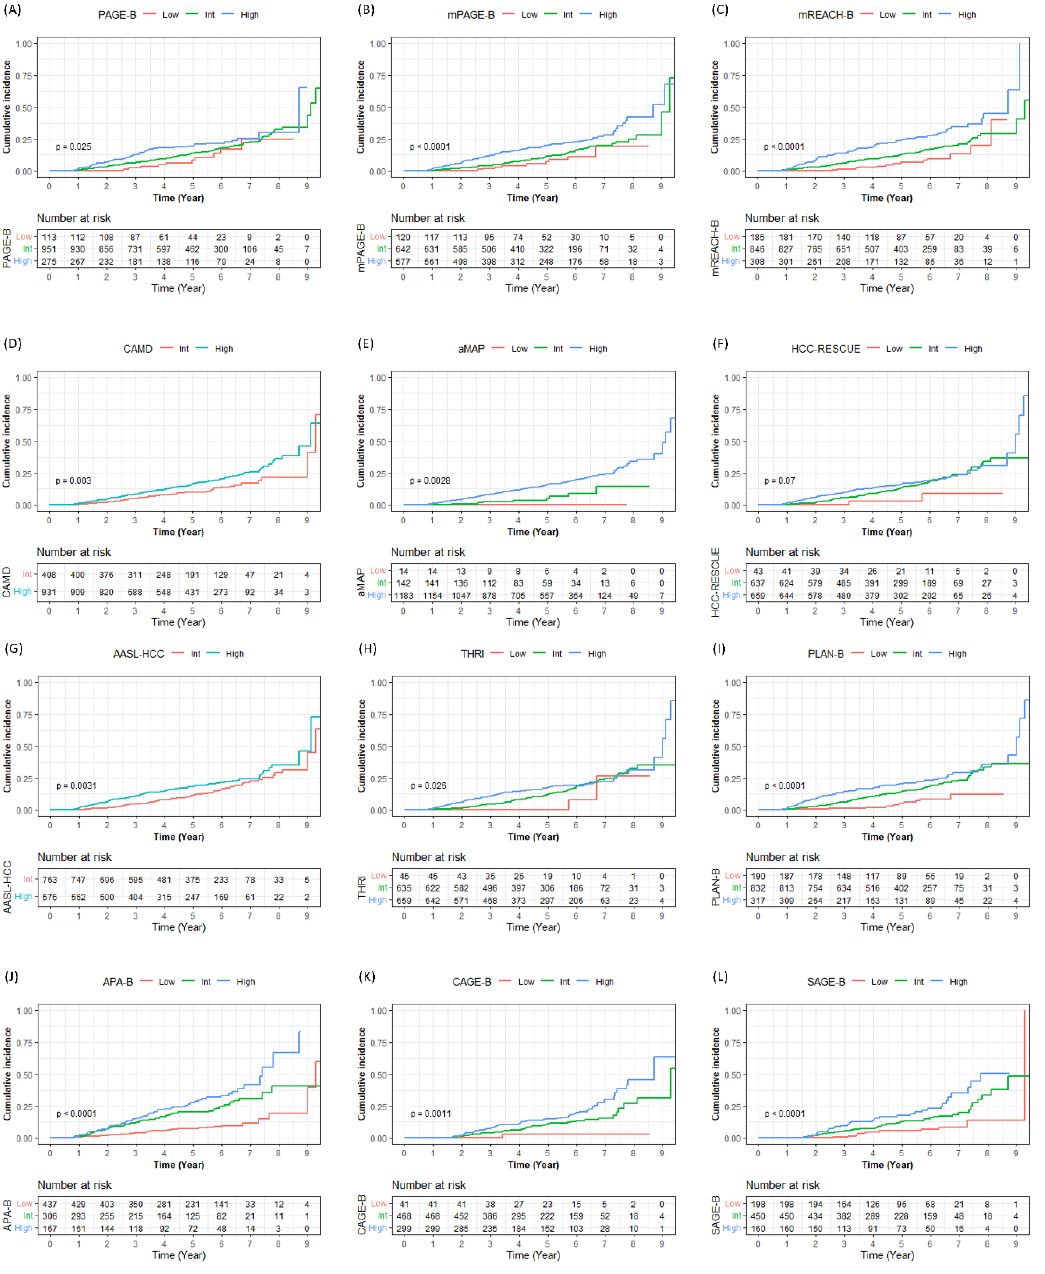
Figure 1. Risk stratification of HCC development according to the risk group of each PAGE-B ( A ), mPAGE-B ( B ), mREACH-B ( C ), CAMD ( D ), aMAP ( E ), HCC-RESCUE ( F ), AASL-HCC ( G ), THRI ( H ), PLAN-B ( I ), APA-B ( n = 910) † ( J ), CAGE-B ( n = 808) ‡ ( K ), and SAGE-B ( n = 808) ‡ ( L ) model. † APA-B were calculated for HCC development after 6 months in 910 patients with baseline alpha-fetoprotein result. ‡ CAGE-B and SAGE-B were calculated for HCC development after 18 months in 808 patients, with follow-up transient elastography results after 12 months. Abbreviation: HCC, hepatocellular carcinoma; Low, low-risk group; Int, intermediate-risk group; High, high-risk group; mPAGE-B, modified PAGE-B; mREACH-B, modified REACH-B; THRI, Toronto HCC Risk Index. Table 5. Cumulative incidence of HCC development in patients with treatment-naïve chronic hep- atitis B according to the risk stratification by each risk prediction model.